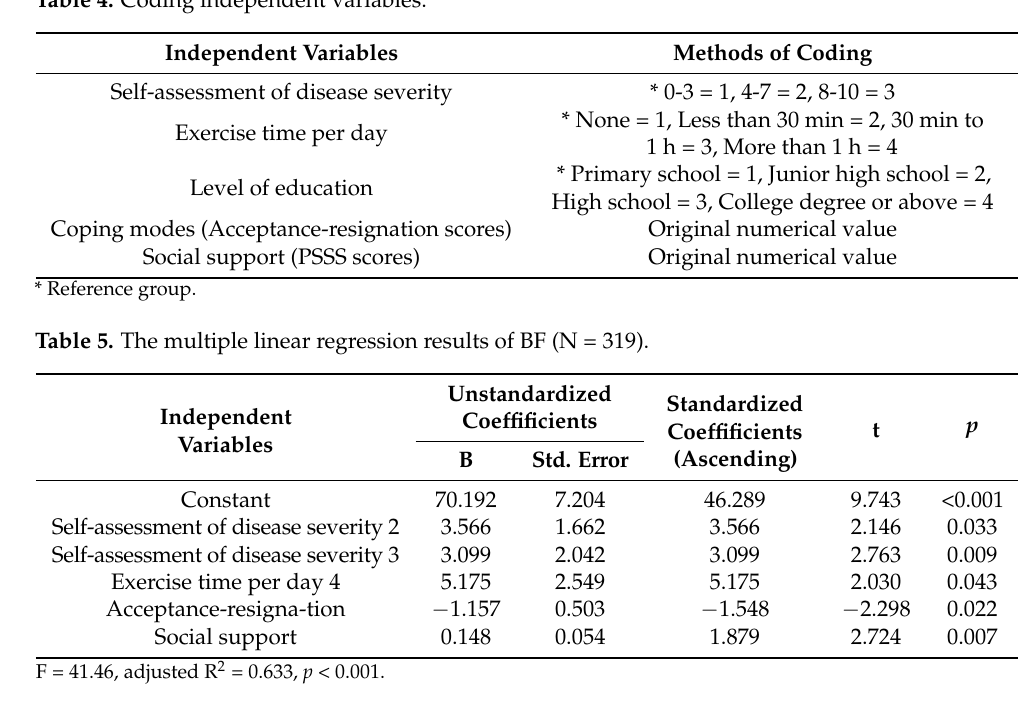
Table 4. Coding independent variables.